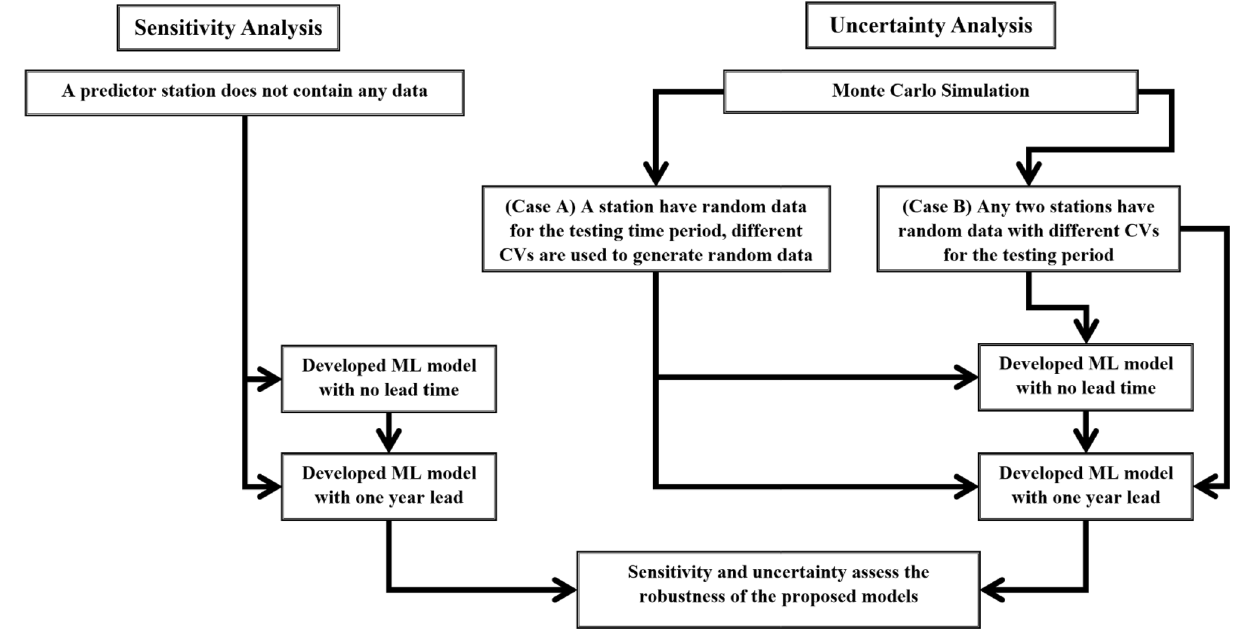
Figure 10. Flow chart of sensitivity and uncertainty analysis in this